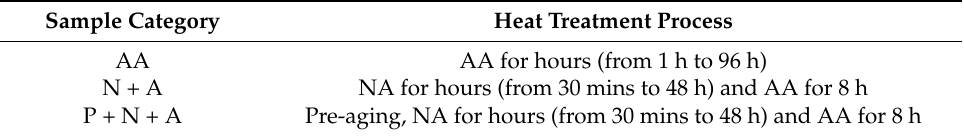
Table 2. Aging processes after solution treatment. The artificial aging (AA), natural aging before AA (N + A), pre-aging before N + A (P + N + A) are single-stage aging, delayed aging, and pre-aging treatment,